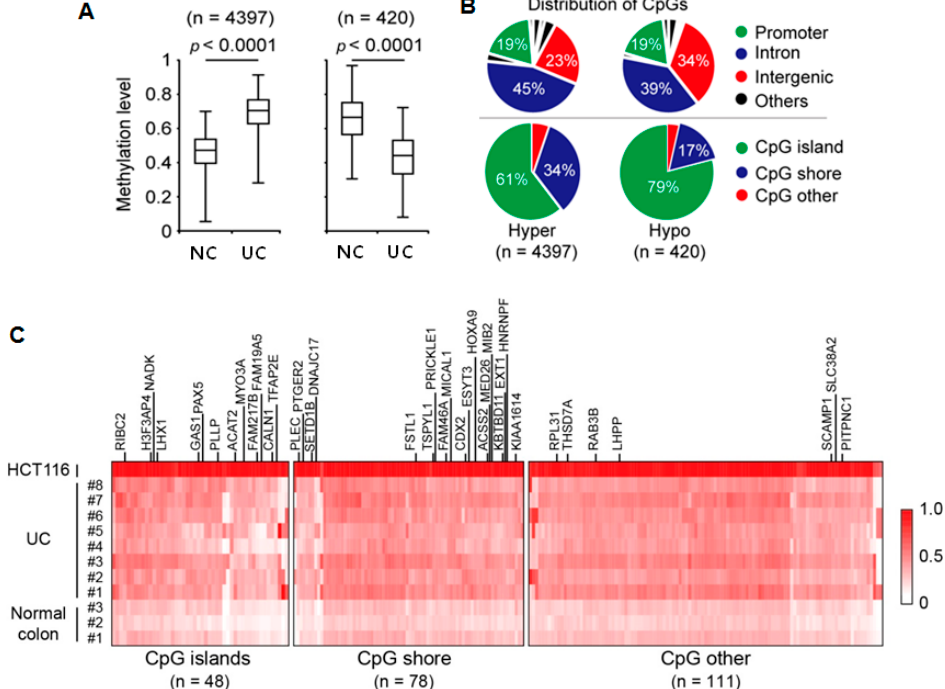
Figure 1. Genome-wide DNA methylation profiles of ulcerative colitis (UC) patients. ( A ) Comparison of genome-wide DNA methylation levels between UC tissues and normal control. 4397 probes showed significantly increased methylation level (hypermethylation) in UC tissues than normal colon (NC). However, 420 probes showed decreased methylation level (hypomethylation) in UC tissues than NC. p -values were calculated by Mann-Whitney U test; ( B ) Distributions of CpGs according to genome annotation. Most altered CpG sites in UC are located in CpG islands near the promoter regions; ( C ) Unsupervised clustering analysis of the normal colon (NC) and UC patient tissues (UC). The color gradient from white to red displays the β -values ranging from 0 (unmethylated) to 1 (fully methylated).